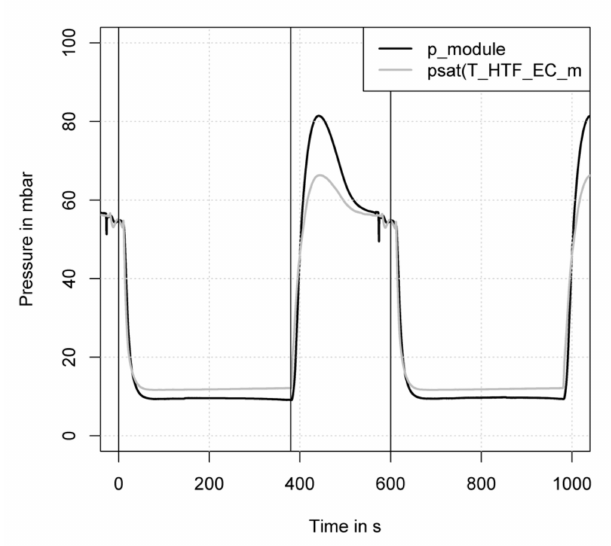
Figure 7. Pressure curves of module and calculated saturation pressure of the evaporator/condenser mean temperature. Temperature boundary conditions are 10/35/95 ◦ C, 400 s adsorption, 200 s desorption half cycle time, volume flow rate is kept constant at 10 L/min for each heat exchanger throughout the whole measurement.